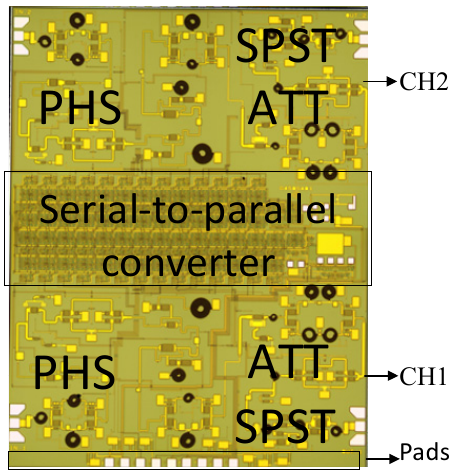
Figure 7. Photograph of the fabricated multi-function chip.